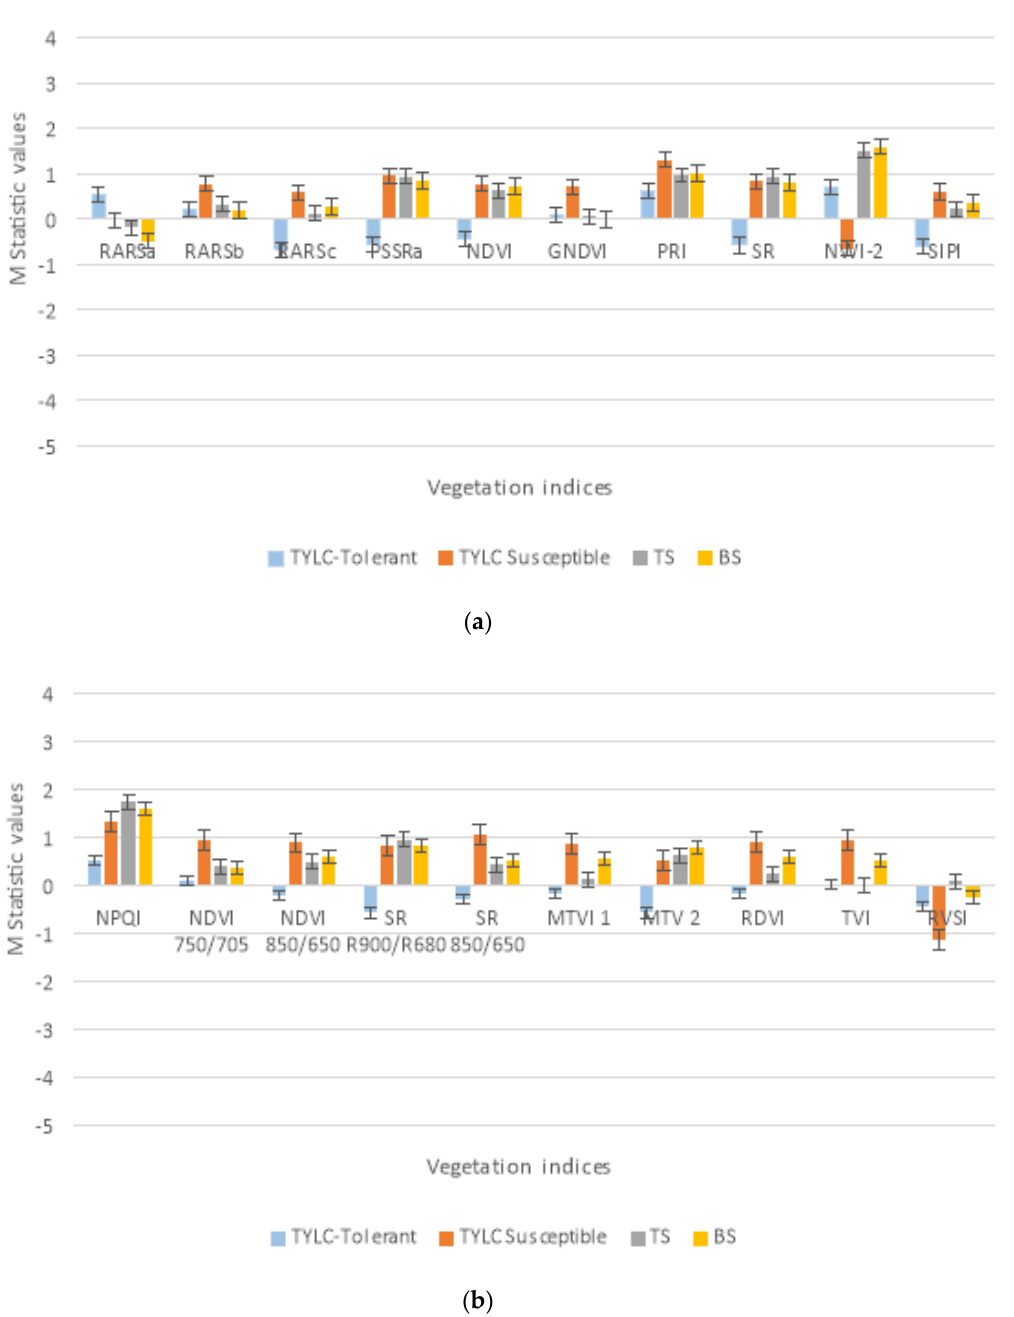
Figure 5. The M statistic value of vegetation indices for TYLC, BS, and TS diseases in the laboratory: ( a ) first group of VIs and ( b ) second group of VIs. The vertical bar represents the error